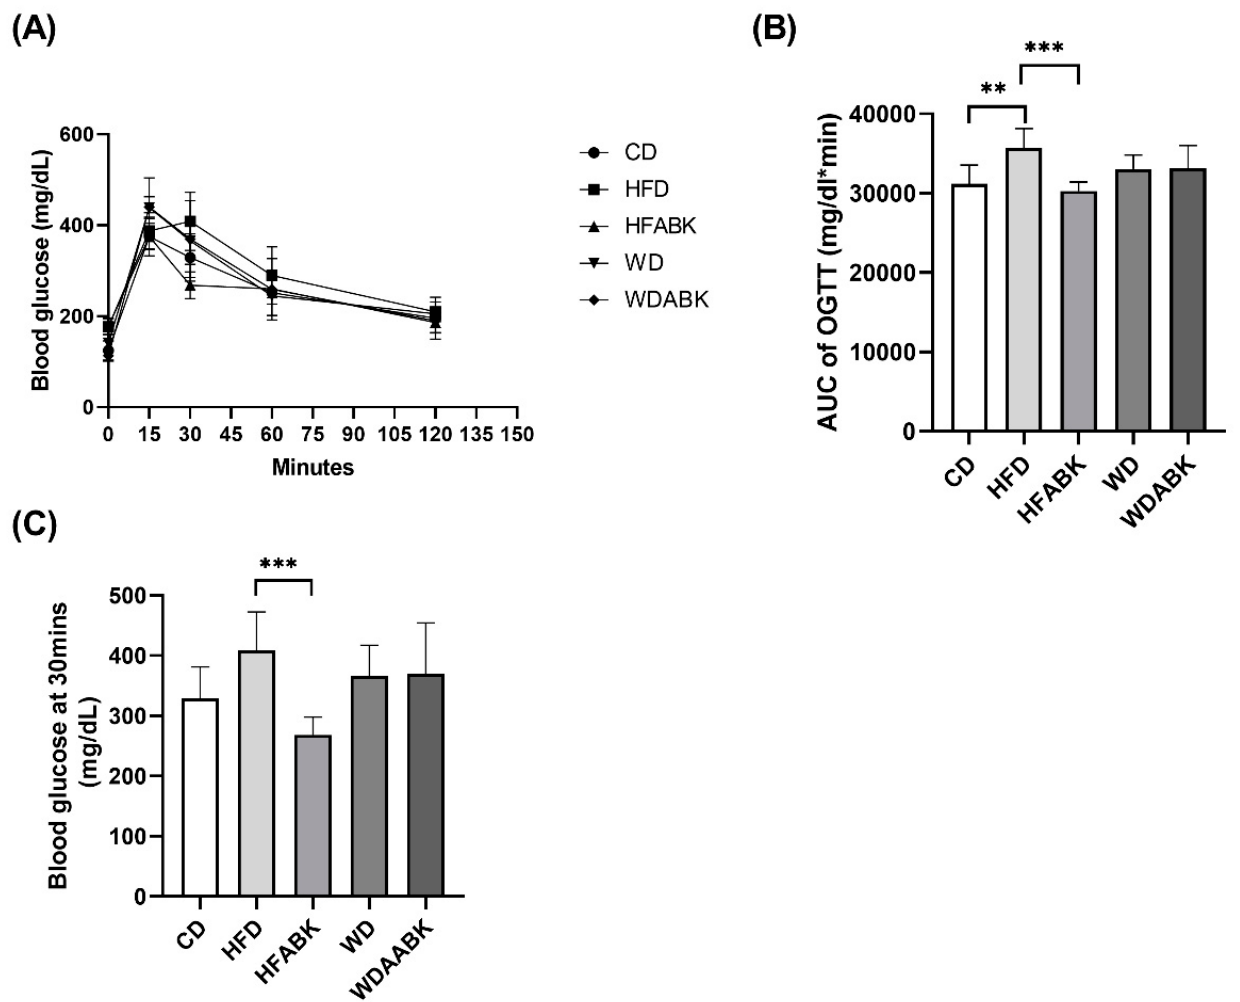
Figure 2. Effect of AB-Kefir on glucose tolerance test in HFD- and WD-fed mice. Overnight-fasted mice were administered 2.0 g/kg BW glucose by gavage. Blood samples were taken at 0, 15-, 30-, 60-, and 120-min post-administration to measure the levels of blood glucose. ( A ) Curve of OGTT, ( B ) AUC of OGTT, and ( C ) glucose level at 30 min of OGTT are shown. Data are expressed as mean ± SD (n = 8 per group). ** p < 0.01, *** p < 0.001. Statistics were analyzed by using one-way ANOVA with Tukey’s post hoc test.